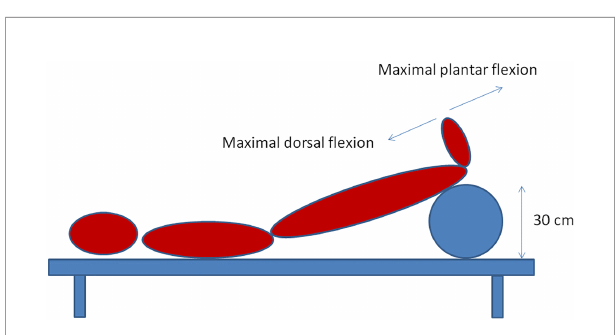
FIGURE 2 | Modi fi ed Ratschow